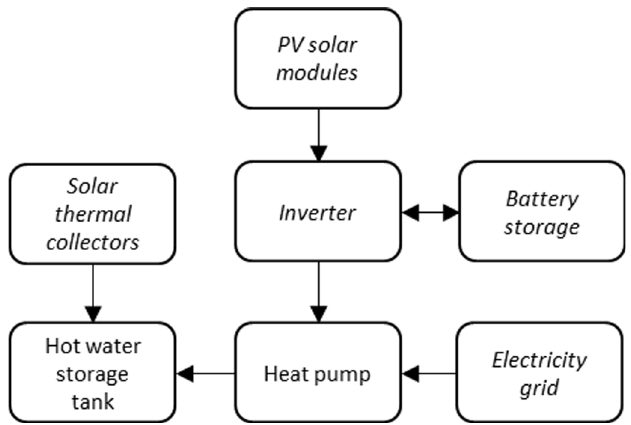
Fig. 1. Con fi guration of the heat pump hot water system scenarios (optional elements shown in italics